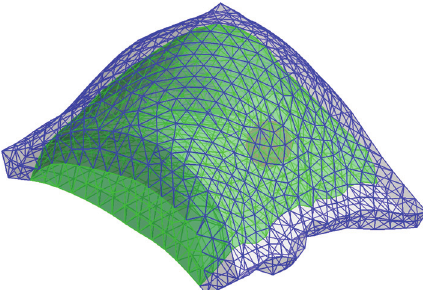
Figure 3: The phantom is discretized with standard 3D tetrahedral elements, consisting of 7303 elements and 1583 nodes.